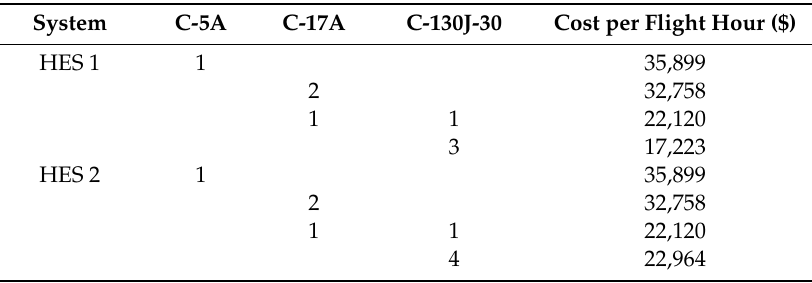
Table 6. All possible airlift combinations for HES 1 and 2 [39].